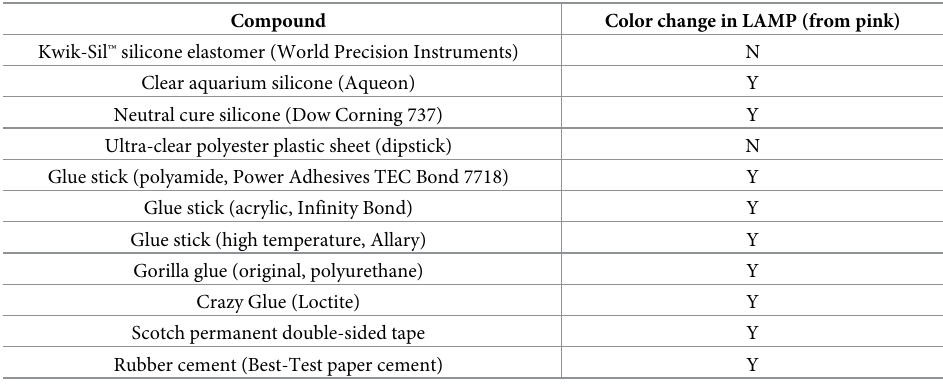
Table 1. Compatibility of materials with colorimetric